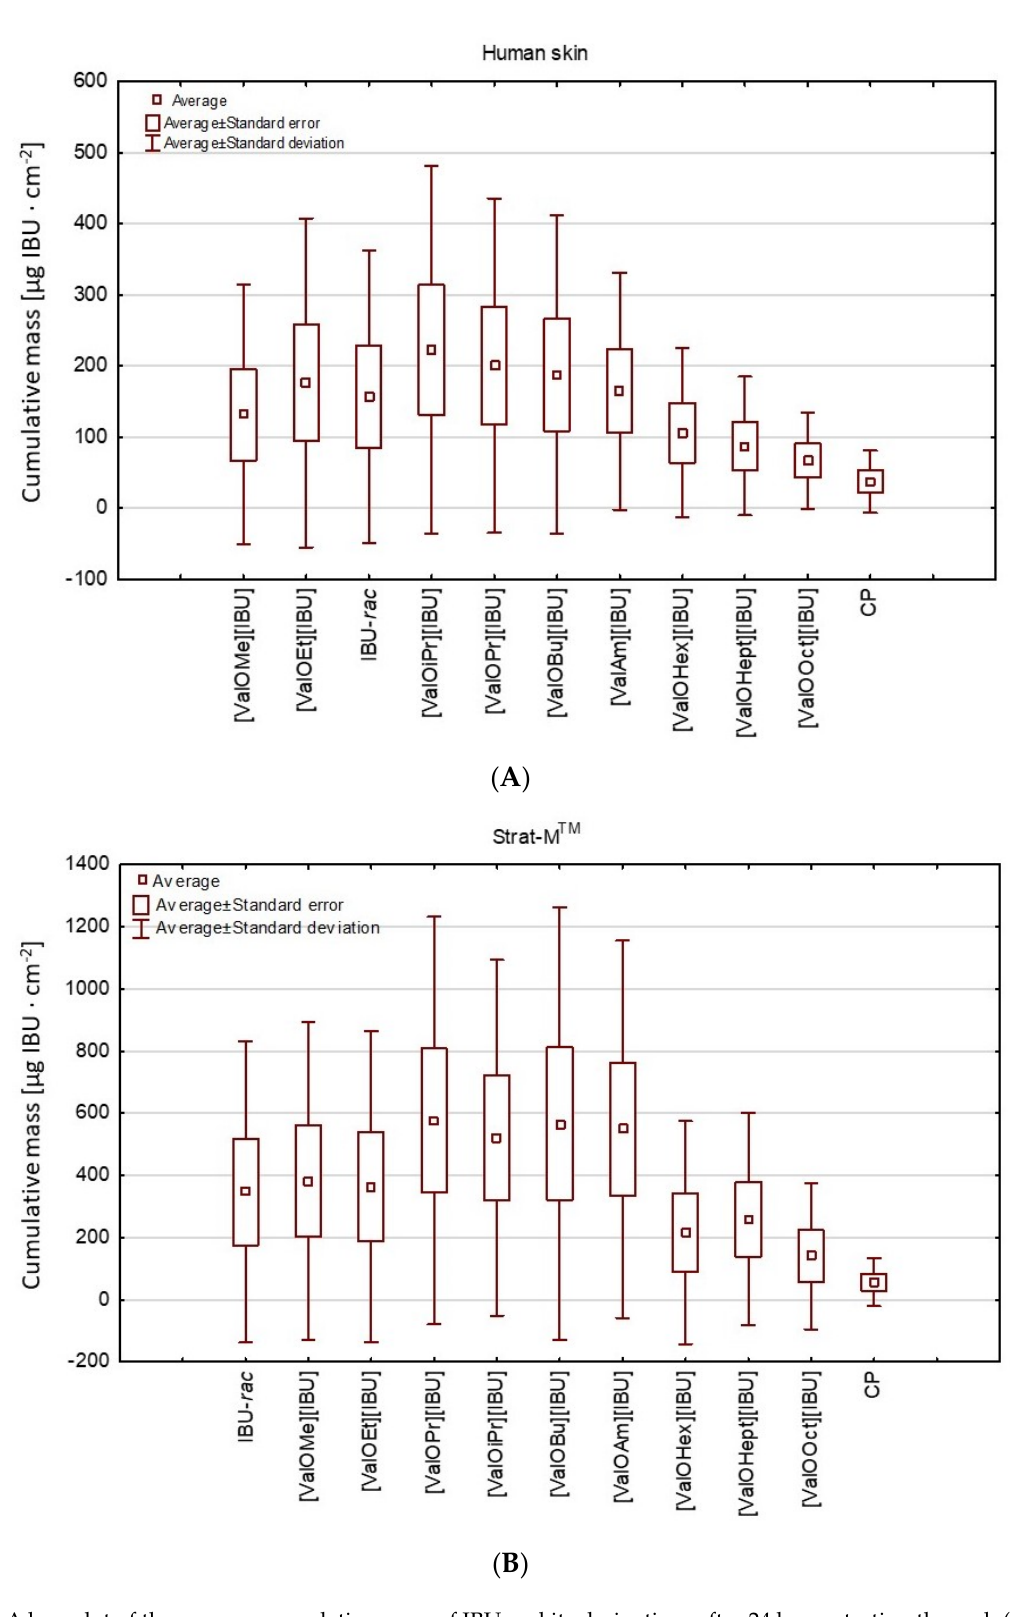
Figure 4. A box plot of the average cumulative mass of IBU and its derivatives after 24 h penetration through ( A ) human skin and ( B ) Strat-M ® membranes; CP—commercial product.